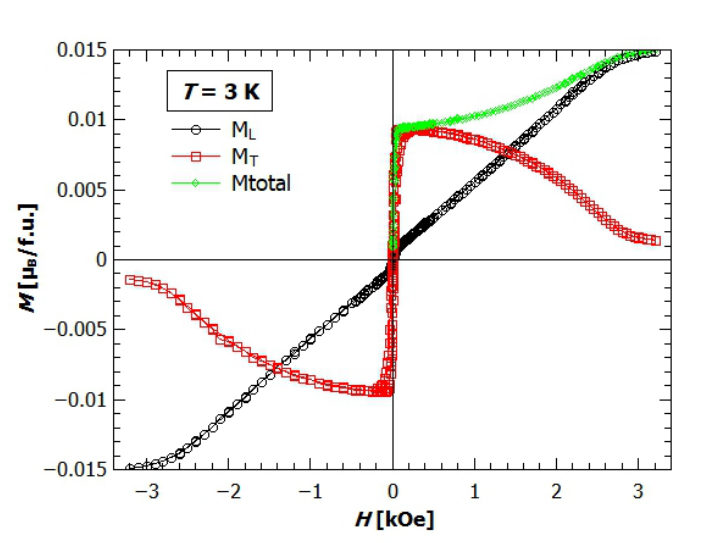
Figure 7. Field dependence of magnetization of single crystal sample of GuaCuF at 3K. Black dots represent the longitudinal magnetization, red rectangles transverse magnetization, and green diamonds total magnetization ( M tot =